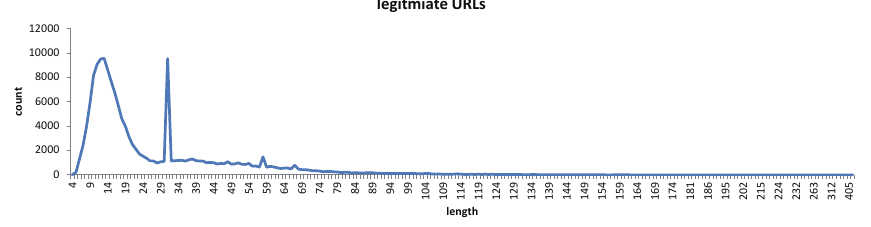
Figure 12. Distribution of URL length in